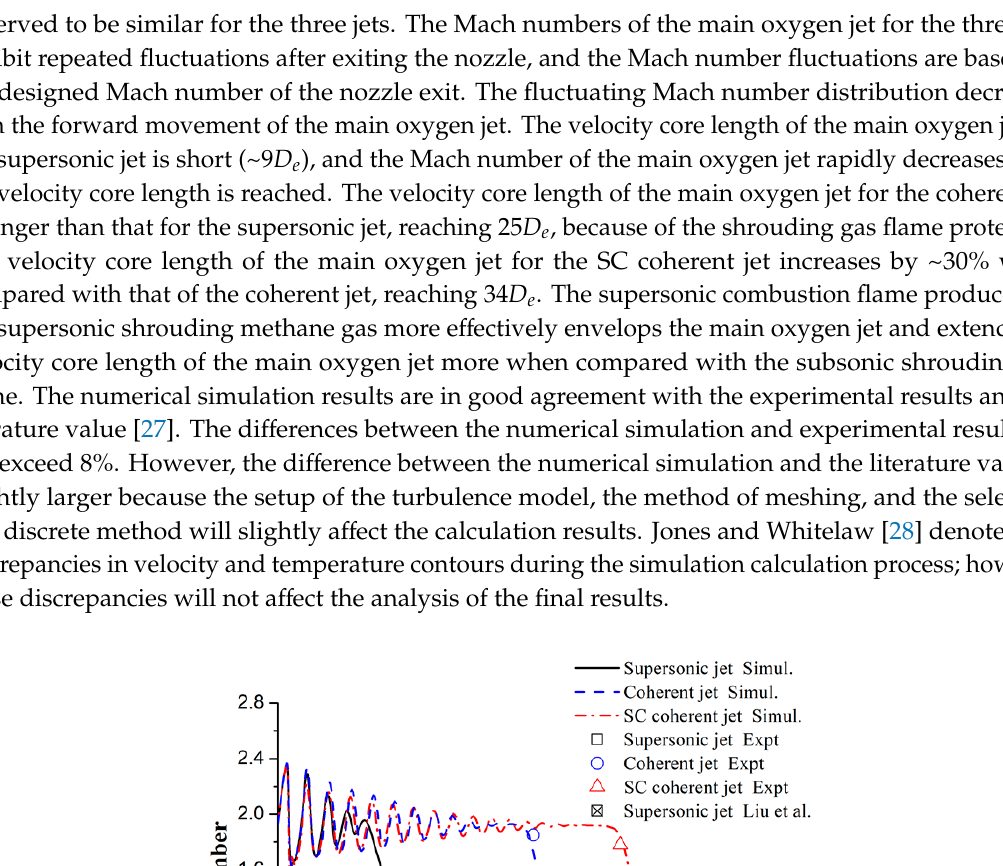
Figure 6. Half-jet width of the main oxygen jet for different jets.